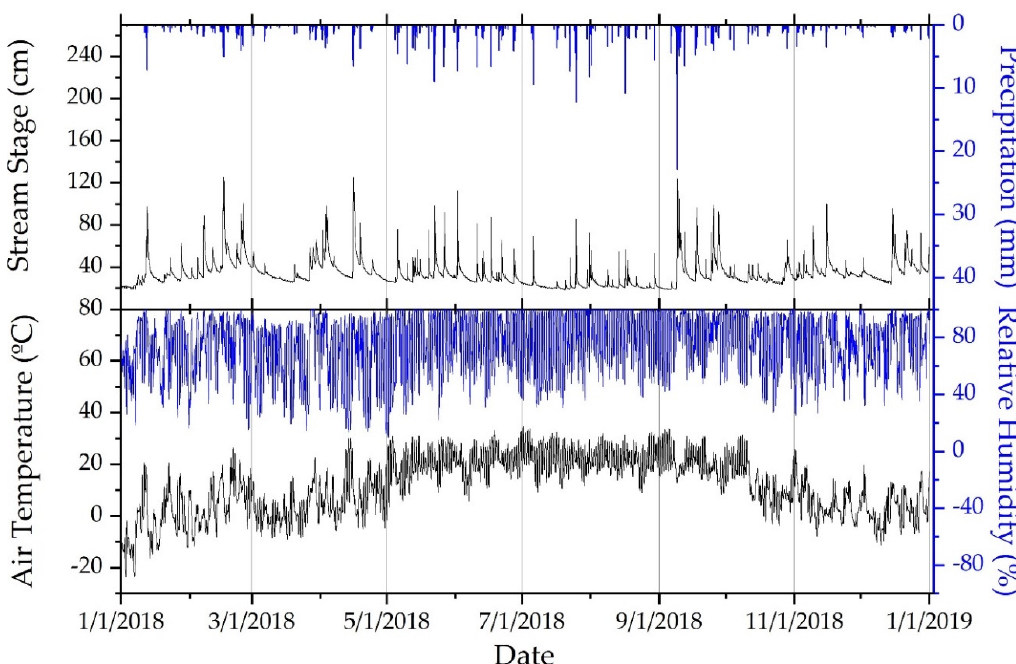
Figure 2. Thirty-minute time series of climate variables during the study period (2 January 2018–1 January 2019) in West Run Watershed, West Virginia, USA. Note: stream stage was measured in the primary stream of WRW, West Run Creek, within approximately 30 m of Site #13 and West Run Creek.